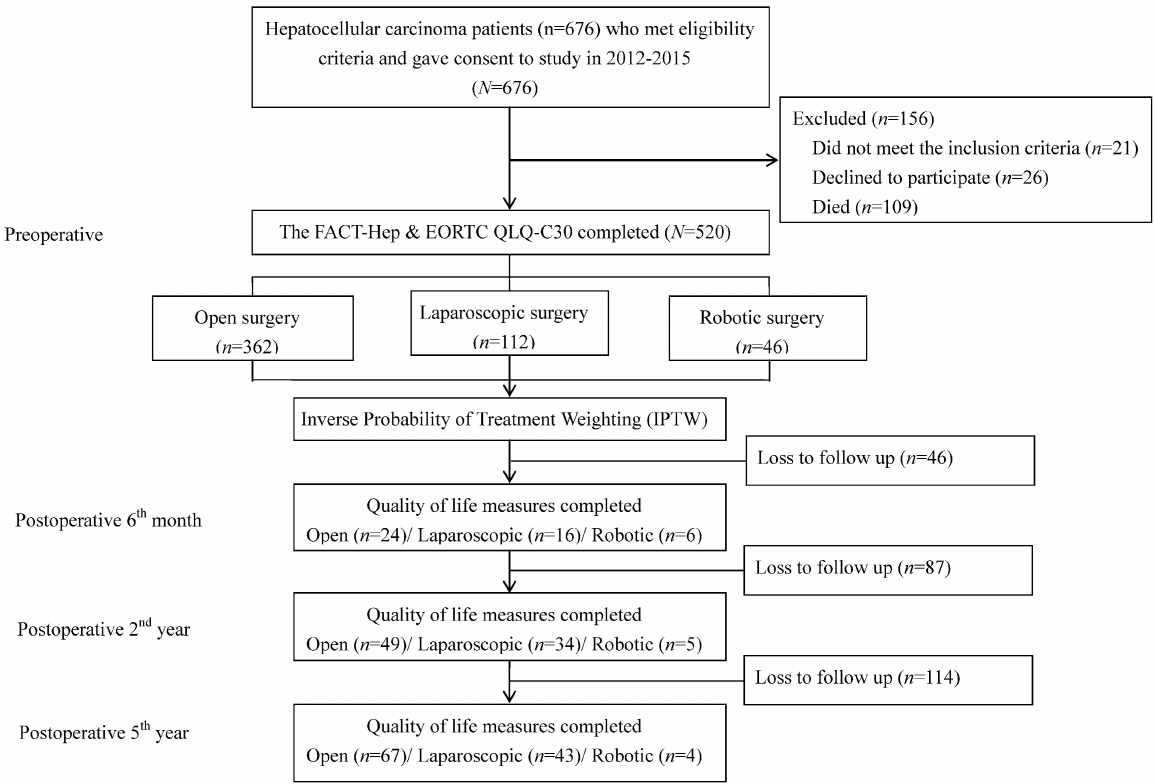
Figure 1. Flowchart of data